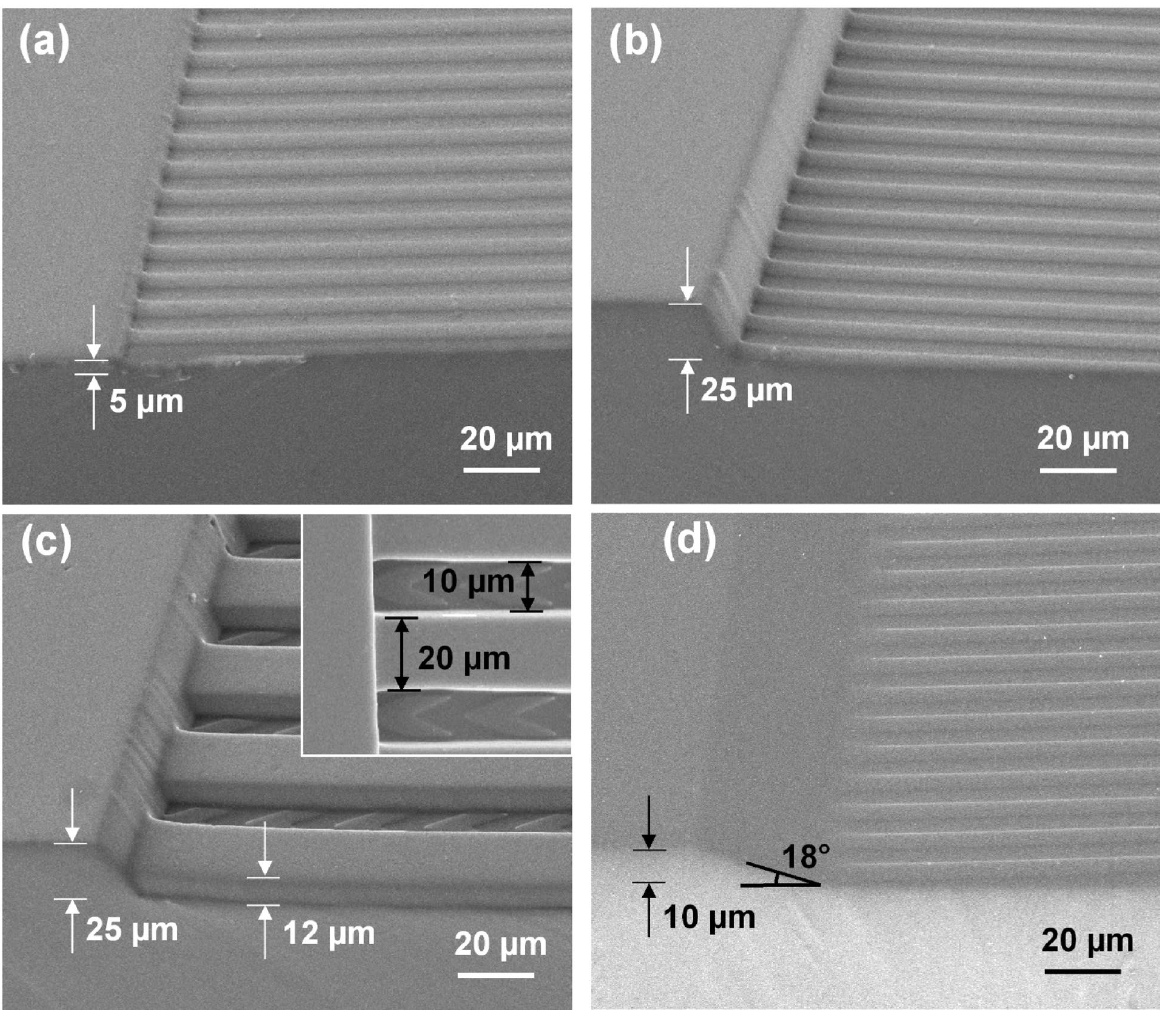
Figure 2. Scanning electron micrographs of PDMS platforms with 1 µm thick, 5 µm wide, and 5 µm spacing grating patterns with ( a ) 5 µm tall and ( b ) 25 µm tall barriers. ( c ) Arrows of 45° angle, 10 µm wide, 26 µm long, and 26 µm spacing between arrowheads in 10 µm wide channels with 20 µm wide and 12 µm thick channel walls next to 25 µm tall barrier. Inserted image on top right is top view of PDMS platform showing dimensions of grating width and spacing. ( d ) Grating with 10 µm tall, 18° sloped